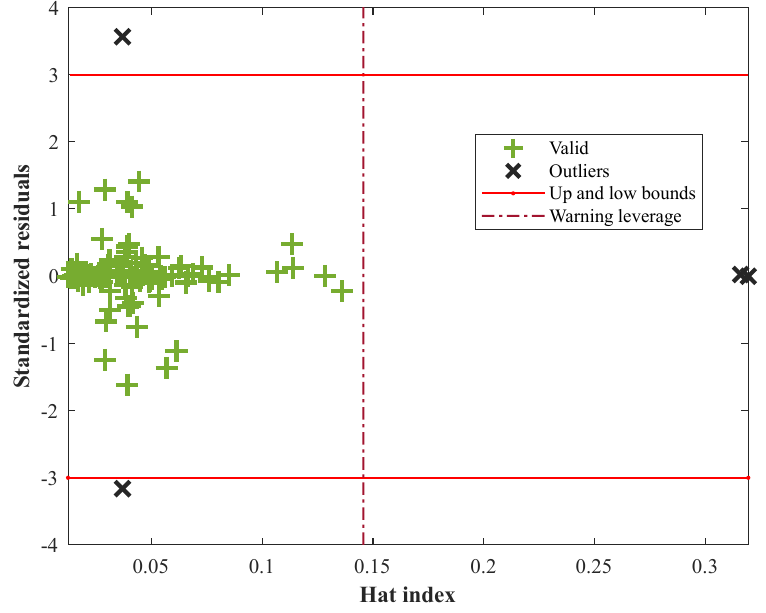
Figure 8. Employing the leverage method to identify undesirable outliers.